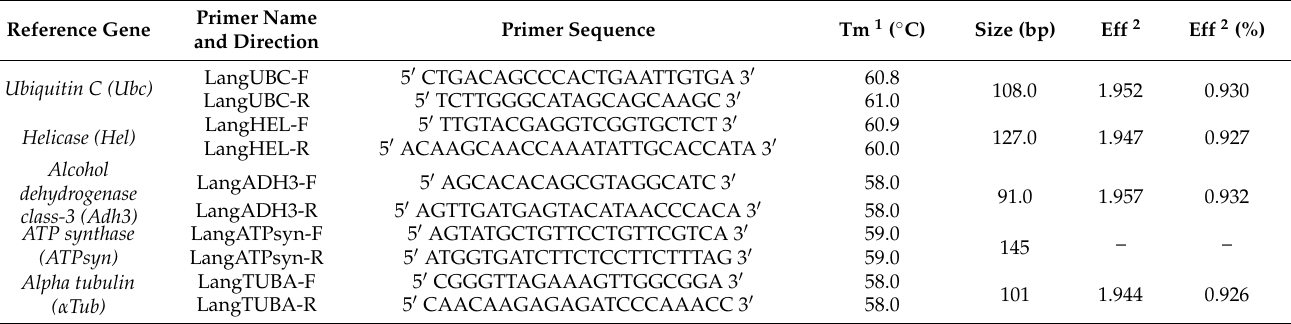
Table 1. Lupinus genes tested as RT-qPCR reference genes for gene expression analysis of tarwi F3H partial gene.